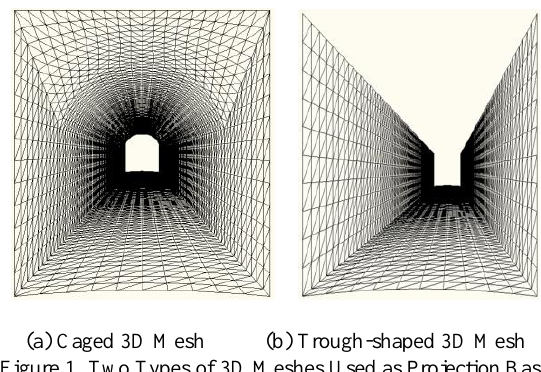
Figure 1. Two Types of 3D Meshes Used as Projection Base Plans for Panoramic Street Strip Image Map Generation.